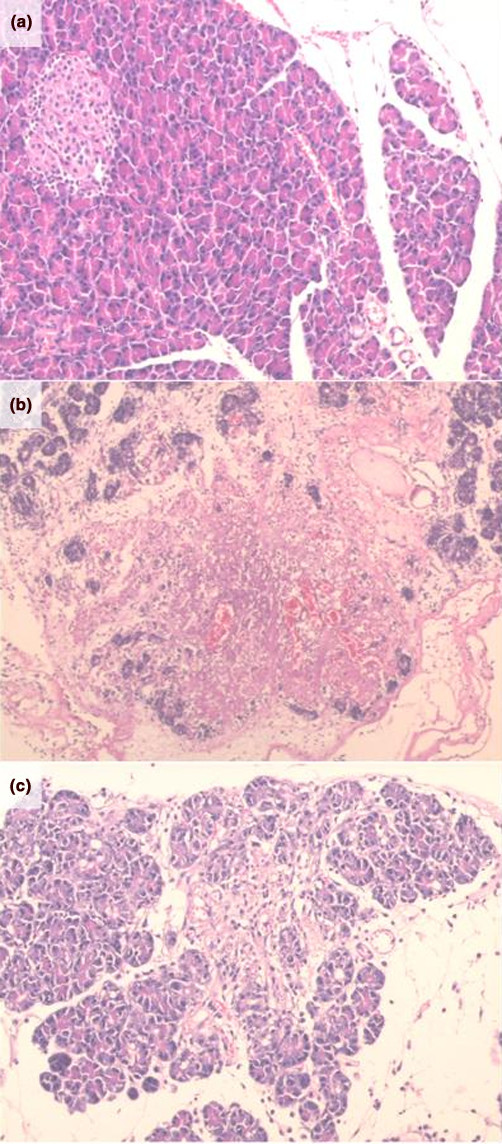
Histology samples from the three groups. (a) Normal pancreatic histology in group I (the sham operated group). (b) Light micrograph showing severe and extensive parenchymal necrosis, with few normal acinar cells in group II (the positive control group). (c) Light micrograph showing mild edema, parenchymal focal necrosis, and inflammation in group III (the activated protein C treated group). All samples were stained with hematoxylin and eosin, and the original magnification for each image is 50×.